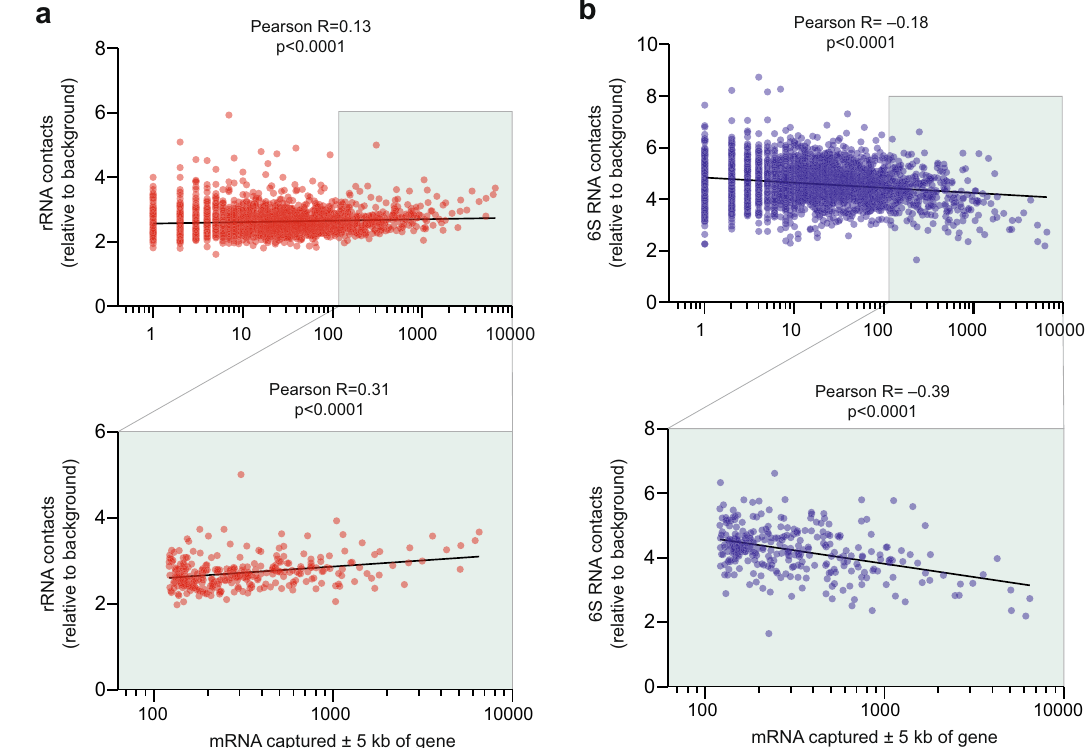
Fig. 3 Contacts of rRNA and 6S RNA with protein-coding genes in E. coli . a Background-normalized contacts of rRNA with individual protein-coding genes (Y-axis) vs the number of contacts of respective mRNAs within ±5 kb from the middle of the gene (X-axis). The scatter plot below presents the results for the rightmost 10% points of the scatter plot above. The black lines — linear regression. b The same as ( a ) for 6S RedC procedure . RedC procedure was performed as described previously in ref. 16 with minor modi fi cations. We used 2.5mL of an overnight culture of E. coli and B . subtilis and 300 mL of T. adornatum culture per experiment. Cells were centrifuged for 10min at 3200 × g and room temperature for E. coli and B . subtilis and for 15 min at 7200 × g and room temperature for T. adornatum . Cells were washed with PBS, centrifuged again, and fi xed in 3% formaldehyde (Sigma-Aldrich F8775) in PBS for 30min at room temperature, followed by quenching with 375mM glycine. Cells were centrifuged at 4°C as above, washed with cold PBS, and